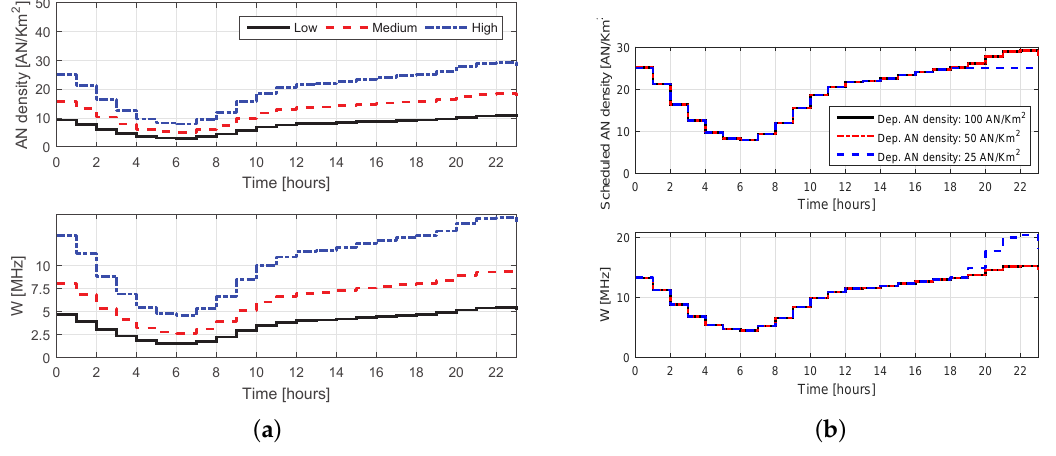
Figure 6. Example of resource density scheduler allocation in UDNs assuming a 1-day traffic intensity profiles from the EARTH project [20], with limitations in bandwidth ( a ) or deployed network density ( b ). ( a ) Resource density scheduling for different deployed network densities assuming a sufficiently large bandwidth (here W max = 100 MHz). ( b ) Resource density scheduling for different deployed network densities assuming a sufficiently large bandwidth (here W max = 100